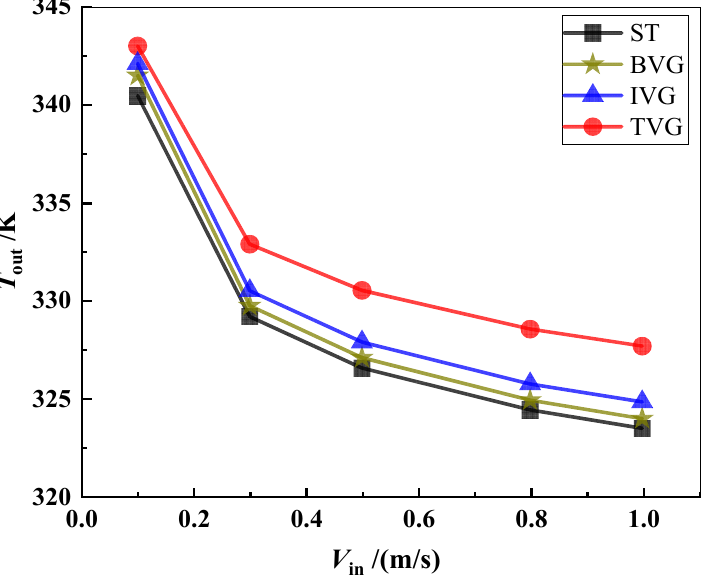
Figure 17. Variation curves of the production temperature of the four heat exchangers with inlet flow velocity.